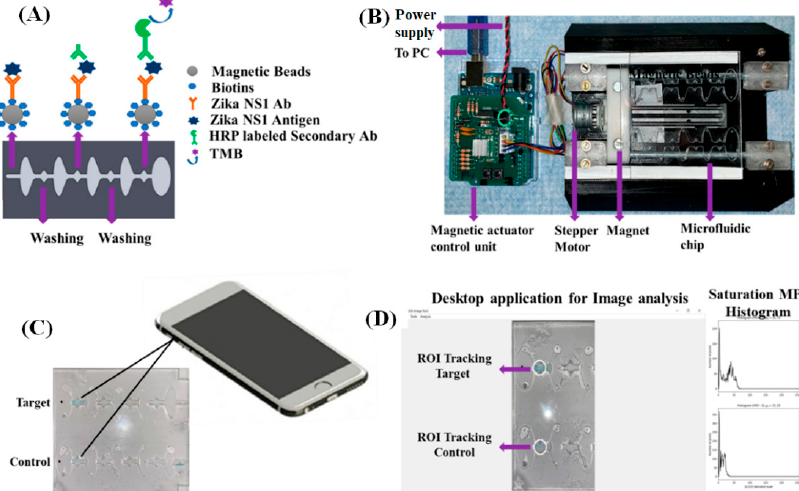
Figure 2. ( A ) Schematic of the enzyme-linked immunosorbent assay (M-ELISA) inside the microfluidic chip; ( B ) Magnetic actuation platform holding the microfluidic chip controlled by Arduino controller allowing bi-directional movement of the magnets; ( C ) Colorimetric changes in the chip were recorded using a smartphone; ( D ) Histogram plot of the saturation maximum pixel intensity (MPI) of the color following the M-ELISA assay on chip [62].